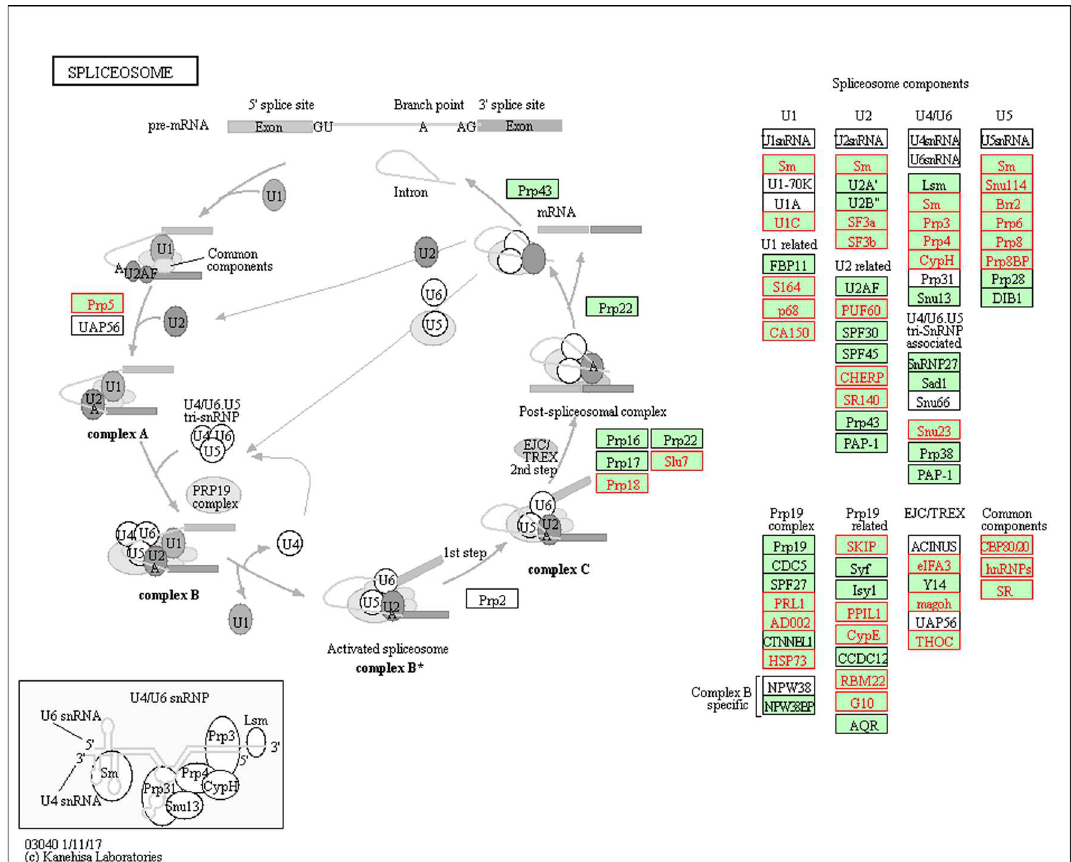
Fig 7. Differentially spliced genes (colored red) associated with the spliceosome